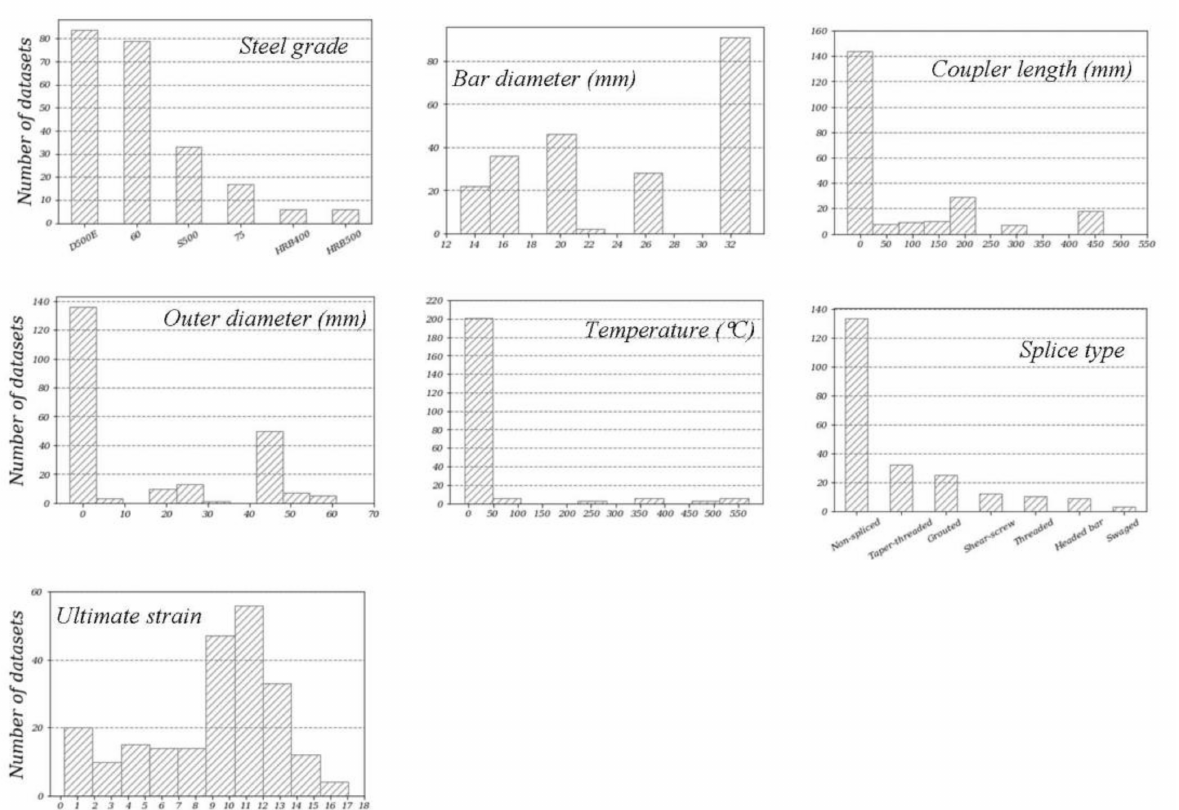
Figure 4. Histograms illustrating the distribution of the input and output